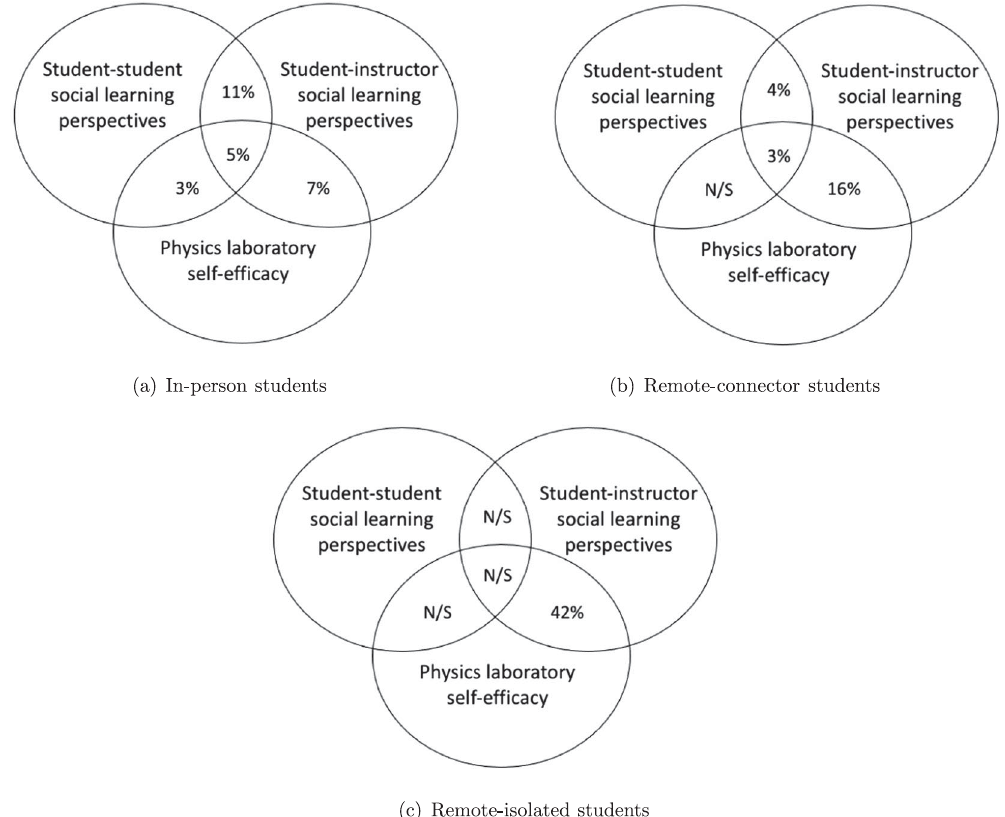
FIG. 2. Shared variance between factors for each group. Factors without significant shared variance are indicated by an “ N/S ”